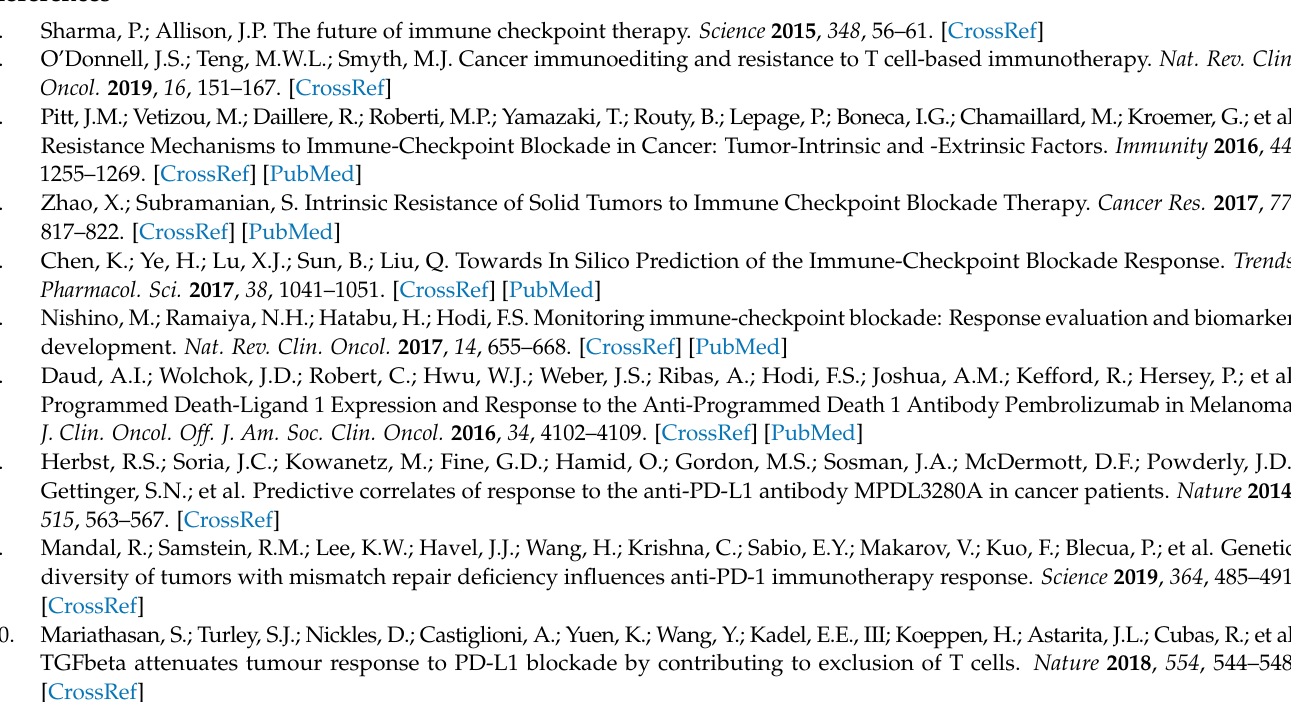
Figure S20: Association assessment between transcriptomic biomarkers and ICB clinical